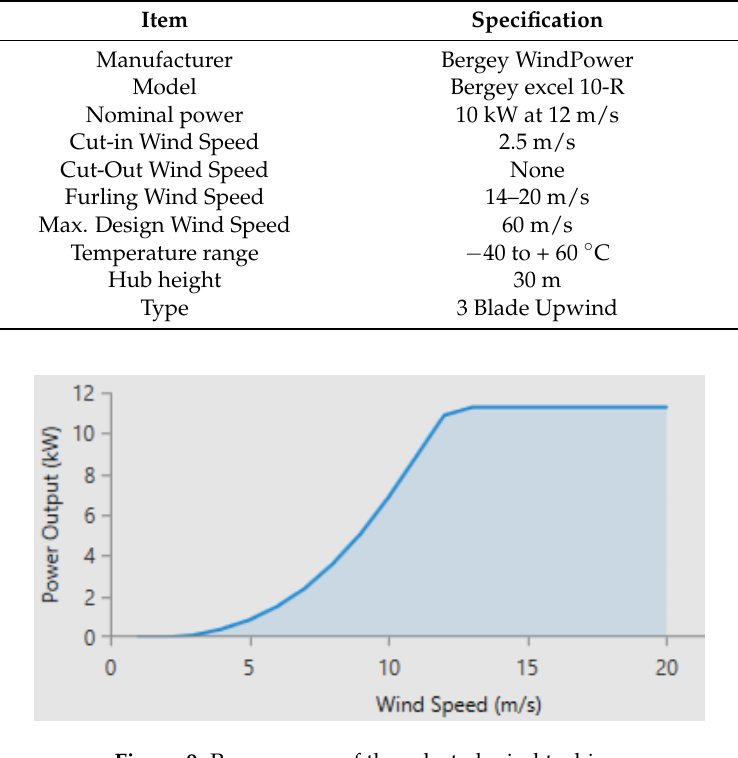
Table 7. Technical specifications of the selected wind turbine model [42].